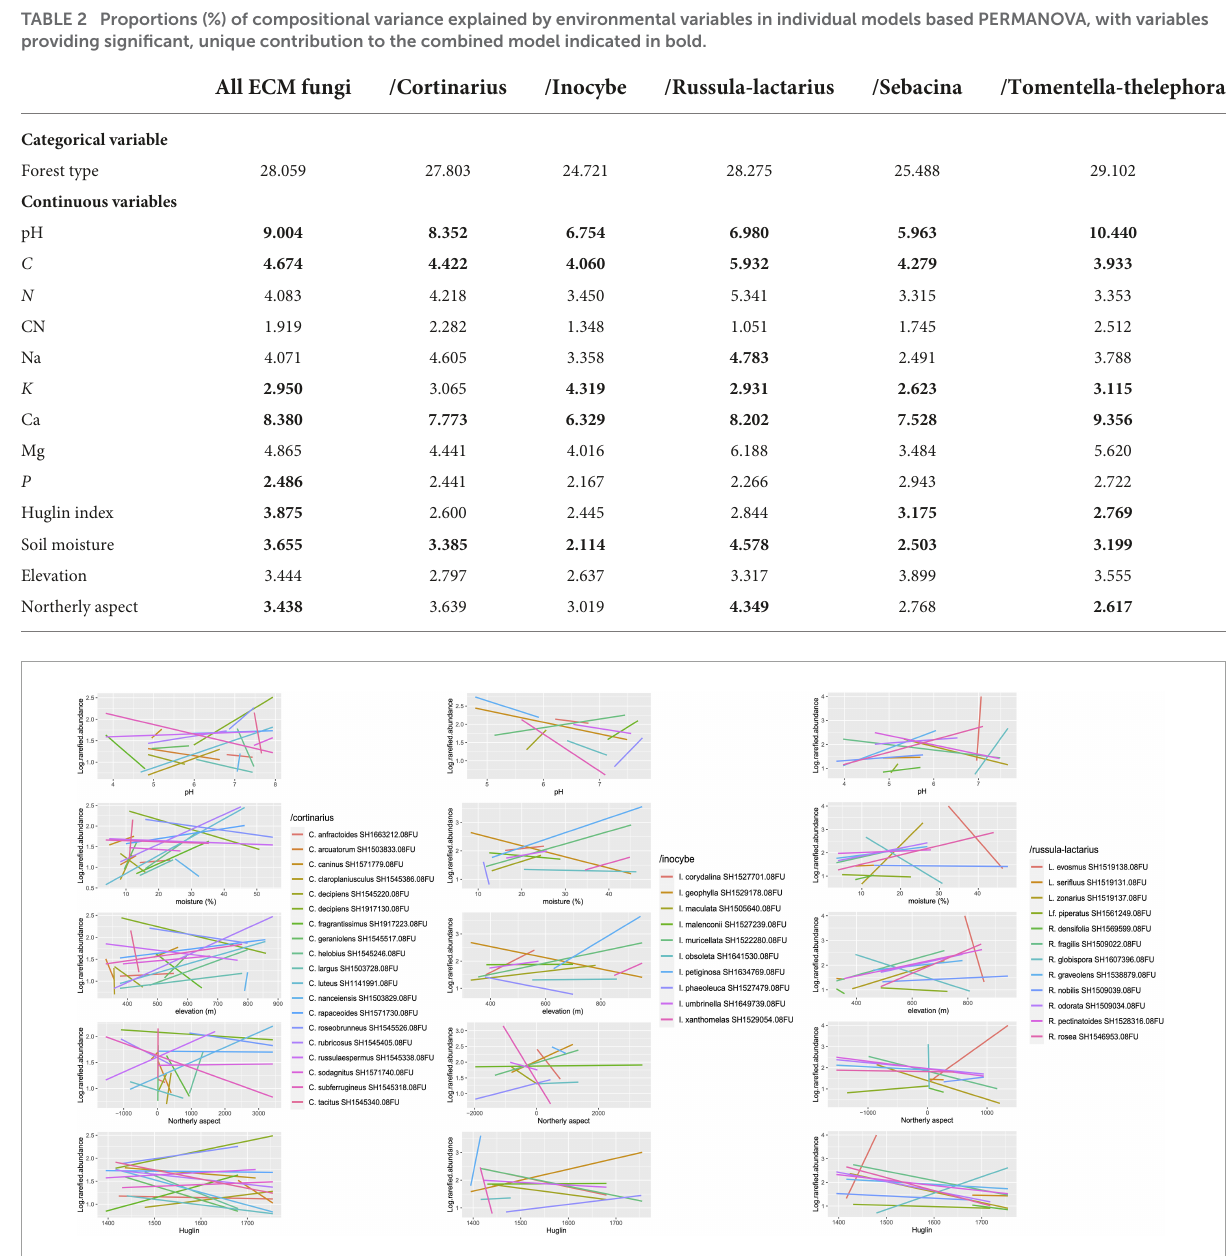
FIGURE5 Correlations between selected environmental variables and log-transformed rarefied read abundance of indicator species of various forest types in three dominant ectomycorrhizal (ECM) fungal lineages. The slopes and the positioning of the regression lines along the x axis suggest species-level ecological differences within genera. The full list of indicator species can be found in Supplementary Table 2